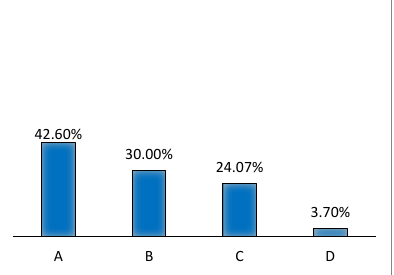
Figure 12. Were the requirements and evaluation criteria of the course clearly defined? A: definitely yes; B: yes; C: no; D: definitely no.